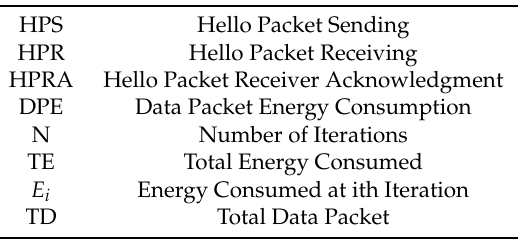
Table 2. Parameters for Energy